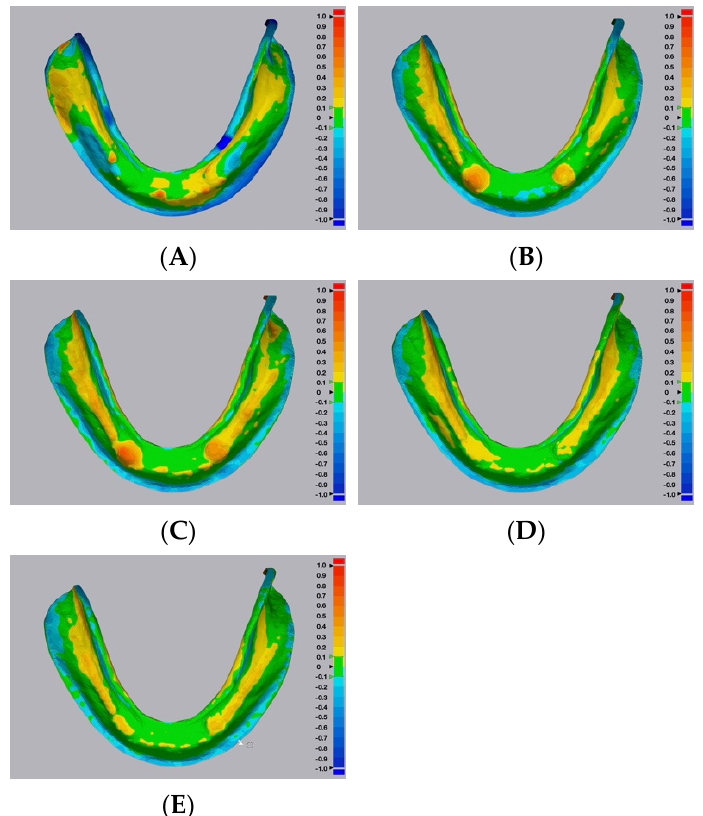
Figure 6. Representative surface matching color maps from the five study groups, across the intaglio portion. ( A ) Group 1—conventional technique. ( B ) Digital—CBCT—DLP 3D printer. ( C ) Digital— CBCT—SLA 3D printer. ( D ) Digital—Laboratory Scanner—DLP 3D printer. ( E ) Digital—Laboratory Scanner—SLA 3D printer.